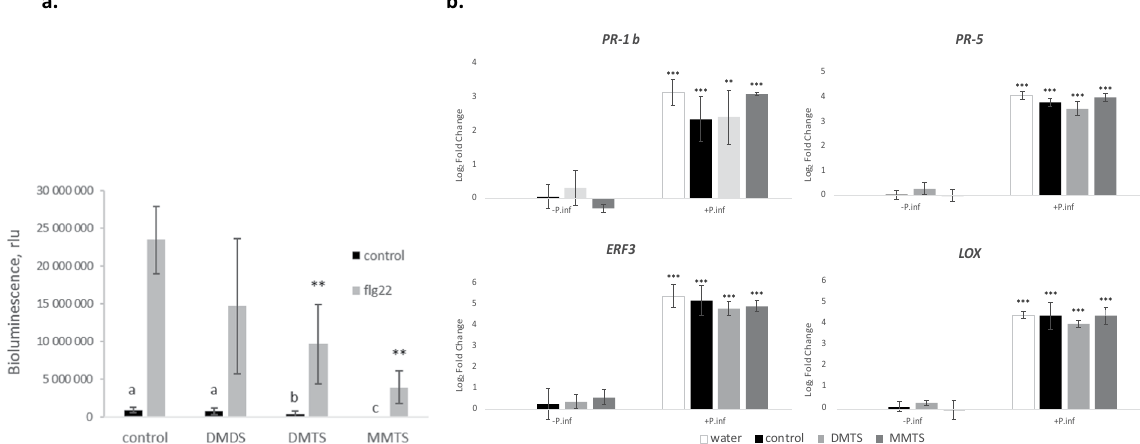
Figure 5. The effect of sVOCs on plant defence responses. ( a ) The effect of individual sVOCs (1 μ g) on the flg22-induced oxidative burst in Arabidopsis, measured as the occurrence of bioluminescence from the oxidation of luminol by peroxidase. The bars show averages of six replicates with error bars indicating standard deviation. Significant differences toward control samples according to an ANOVA test are marked by asterisks or letters: ** p < 0.001. These experiments were performed twice with similar results. ( b ) The accumulation of transcripts for defence genes as indicated in the graphs was analyzed by quantitative PCR in potato leaf discs in response to a 6 h treatment with 1 mg of MMTS or solvent control in the absence ( − Pinf) or presence ( + Pinf) of P. infestans . The bars show averages of 3 biological replicates with error bars indicating standard deviation. Significant differences toward control samples according to an ANOVA test are marked by asterisks: ** p < 0.01, *** p <